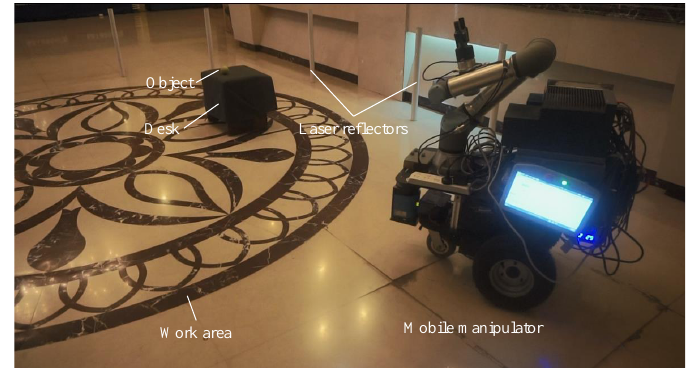
Figure 8. The experimental